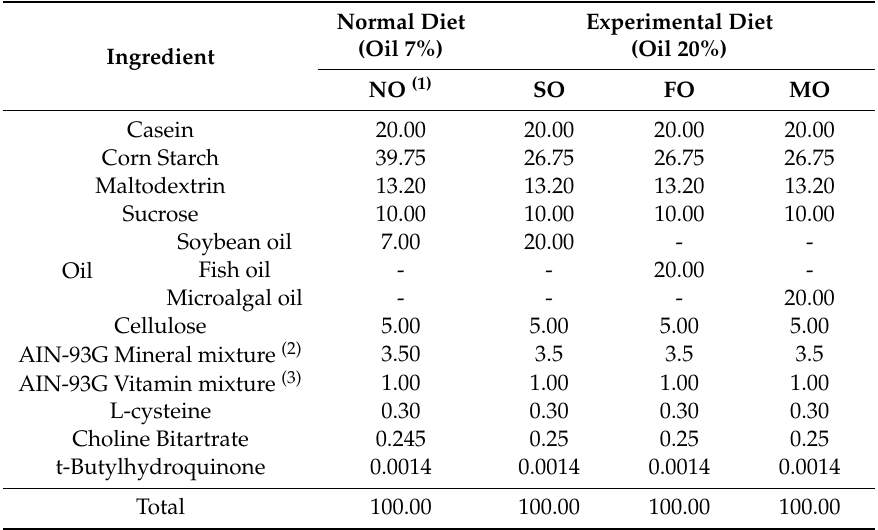
Table 6. The composition of the animal